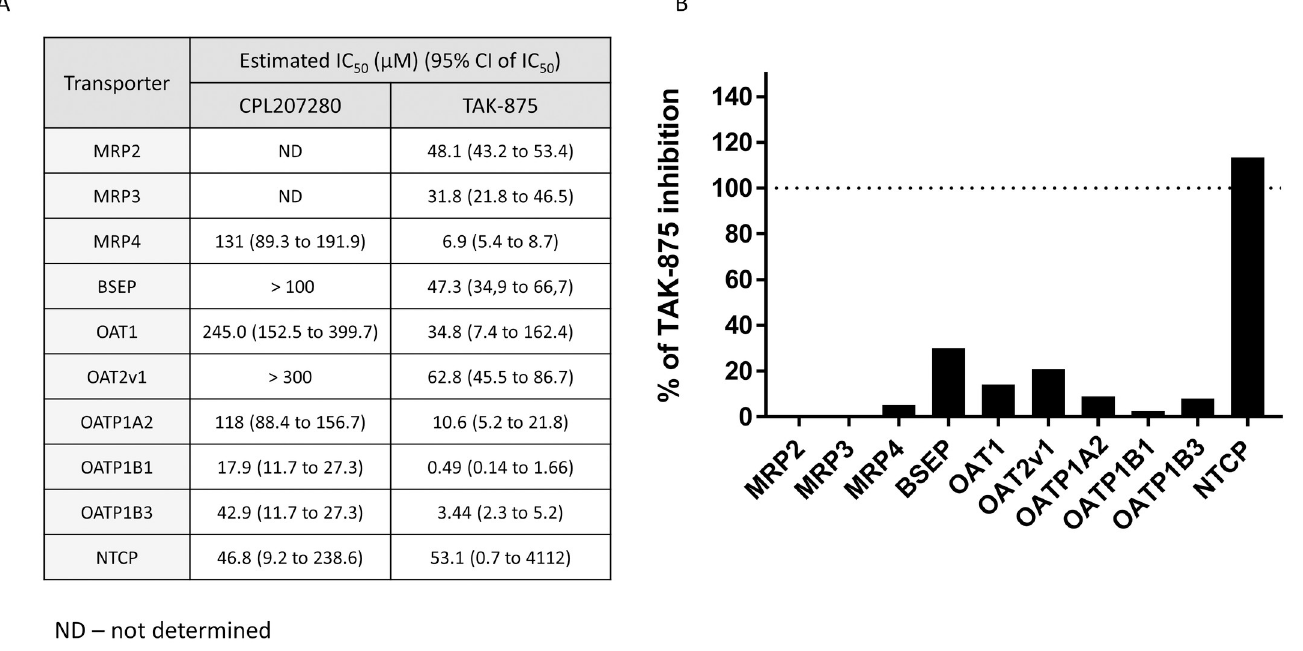
Fig 4. Inhibition of bile acid transporters by test compounds CPL207280 and TAK-875. The transformed HEK cells or vesicles expressing indicated transporters were incubated with a range of concentrations (up to 300 μ M) of test compounds for 1 hour. Next, the inhibition of substrate specific for each transporter was measured. Data represent mean IC 50 (A) and percent of inhibition for CPL207280 relative to that of TAK-875 (B); n = 2.